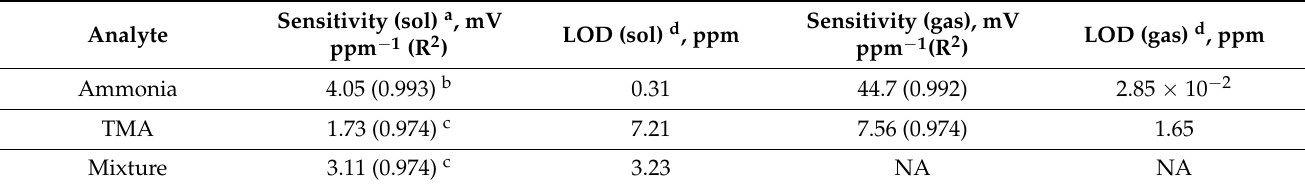
Table 2. Sensitivity and LOD of the DAR/TSPP+PSS (0.025 wt%) film obtained when the solution and gas concentrations for ammonia and TMA were